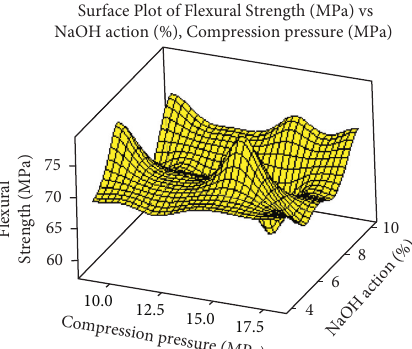
Figure 9: Flexural strength: surface plot of compression pressure and NaOH action.